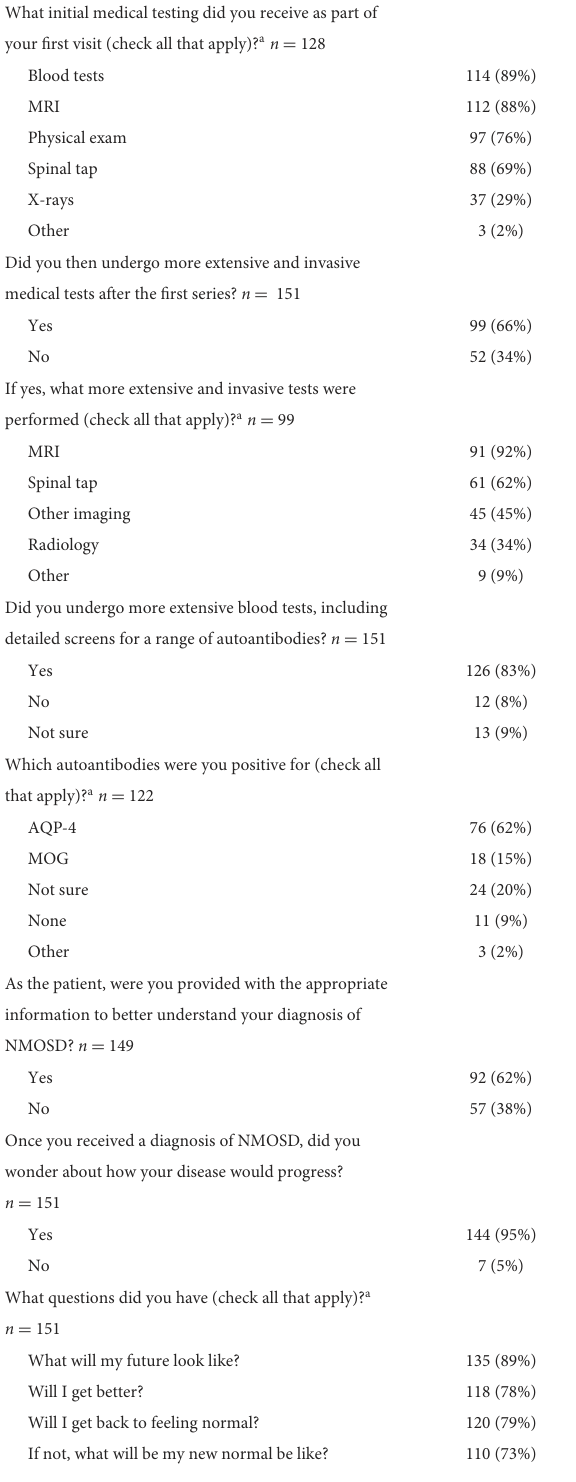
TABLE 4 Medical procedures/tests informing the diagnosis of NMOSD. Question Responses, no. (%)